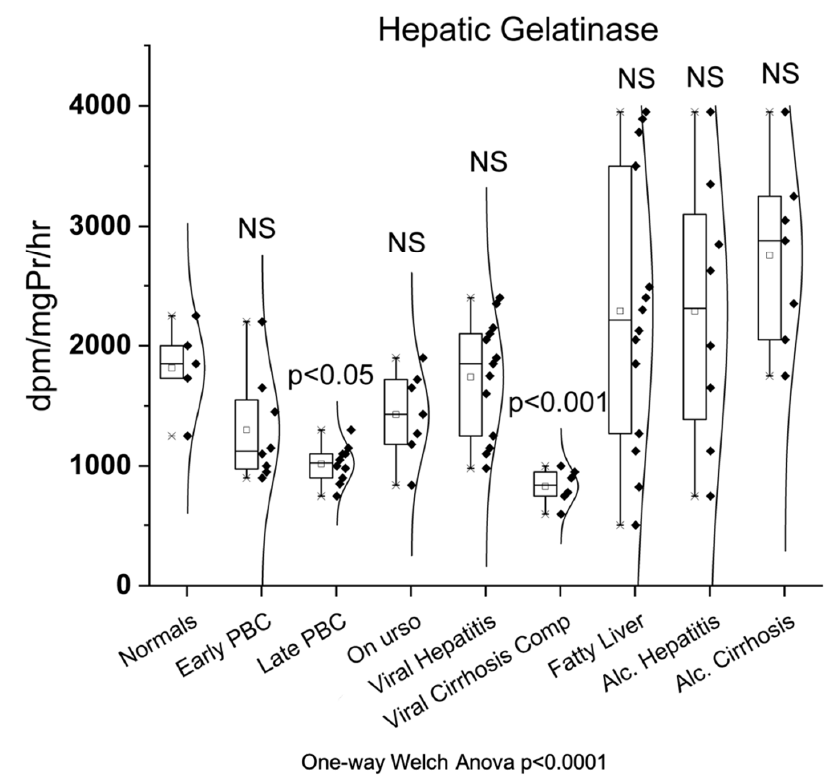
Figure 4. Enzymatic activity of hepatic gelatinase in all studied groups.